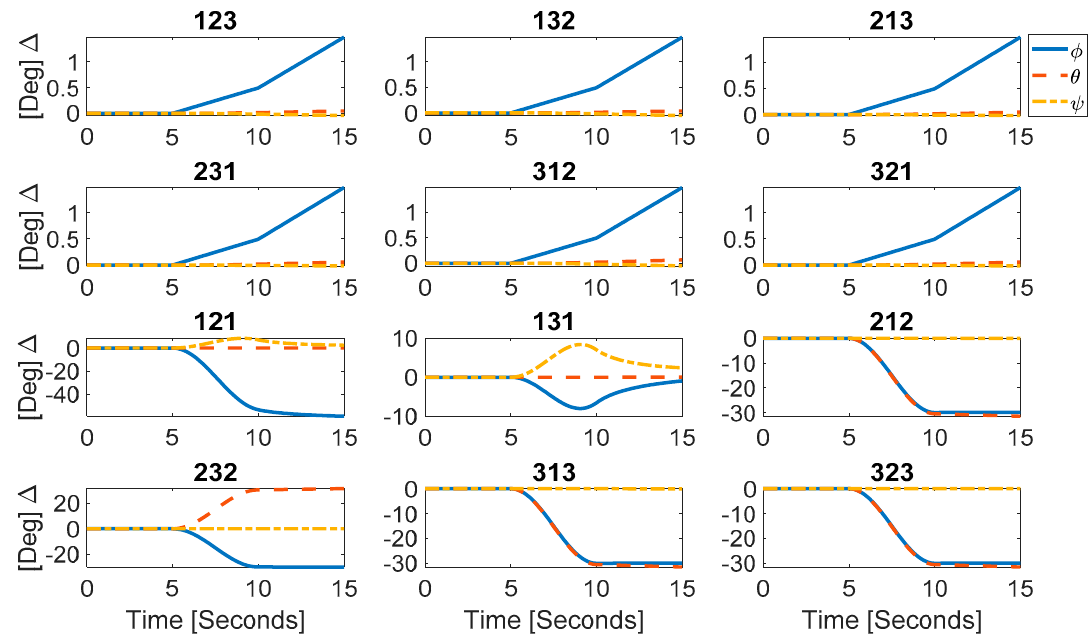
Figure 4. Euler and Body Angle deviation, using a 0.1 step size. Figure 5. Euler and Body Angle deviation, using a 0.001 step